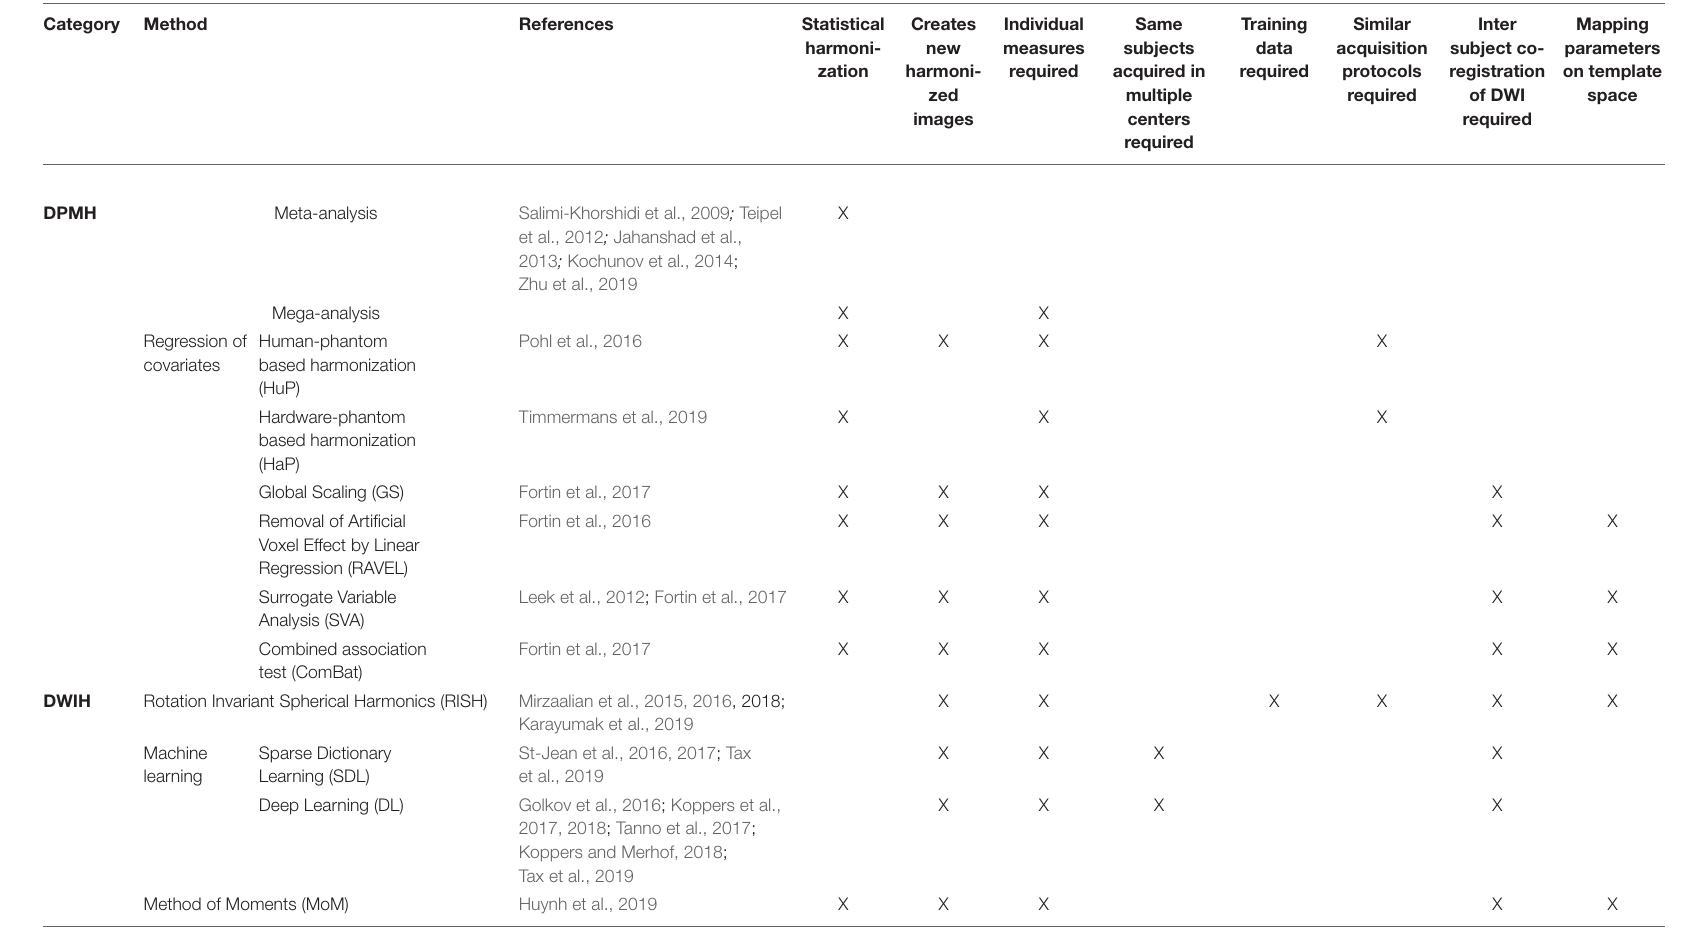
Comparison between the methods related to: implementation of statistical harmonization, creation of new harmonized images, requirement of individual measures, requirement of images from the same subjects acquired in multiple centers, requirement of training data (i.e., matched subjects across sites are needed for obtaining the mapping between sites), requirement of similar acquisition protocols (i.e., diffusion directions, b-values, spatial resolution, TR, TE, SNR, etc.), requirement of inter subject co-registration, and implementation of mapping between sites through mapping parameters on template space. The X denotes if the method requires or performs the specific condition described in the